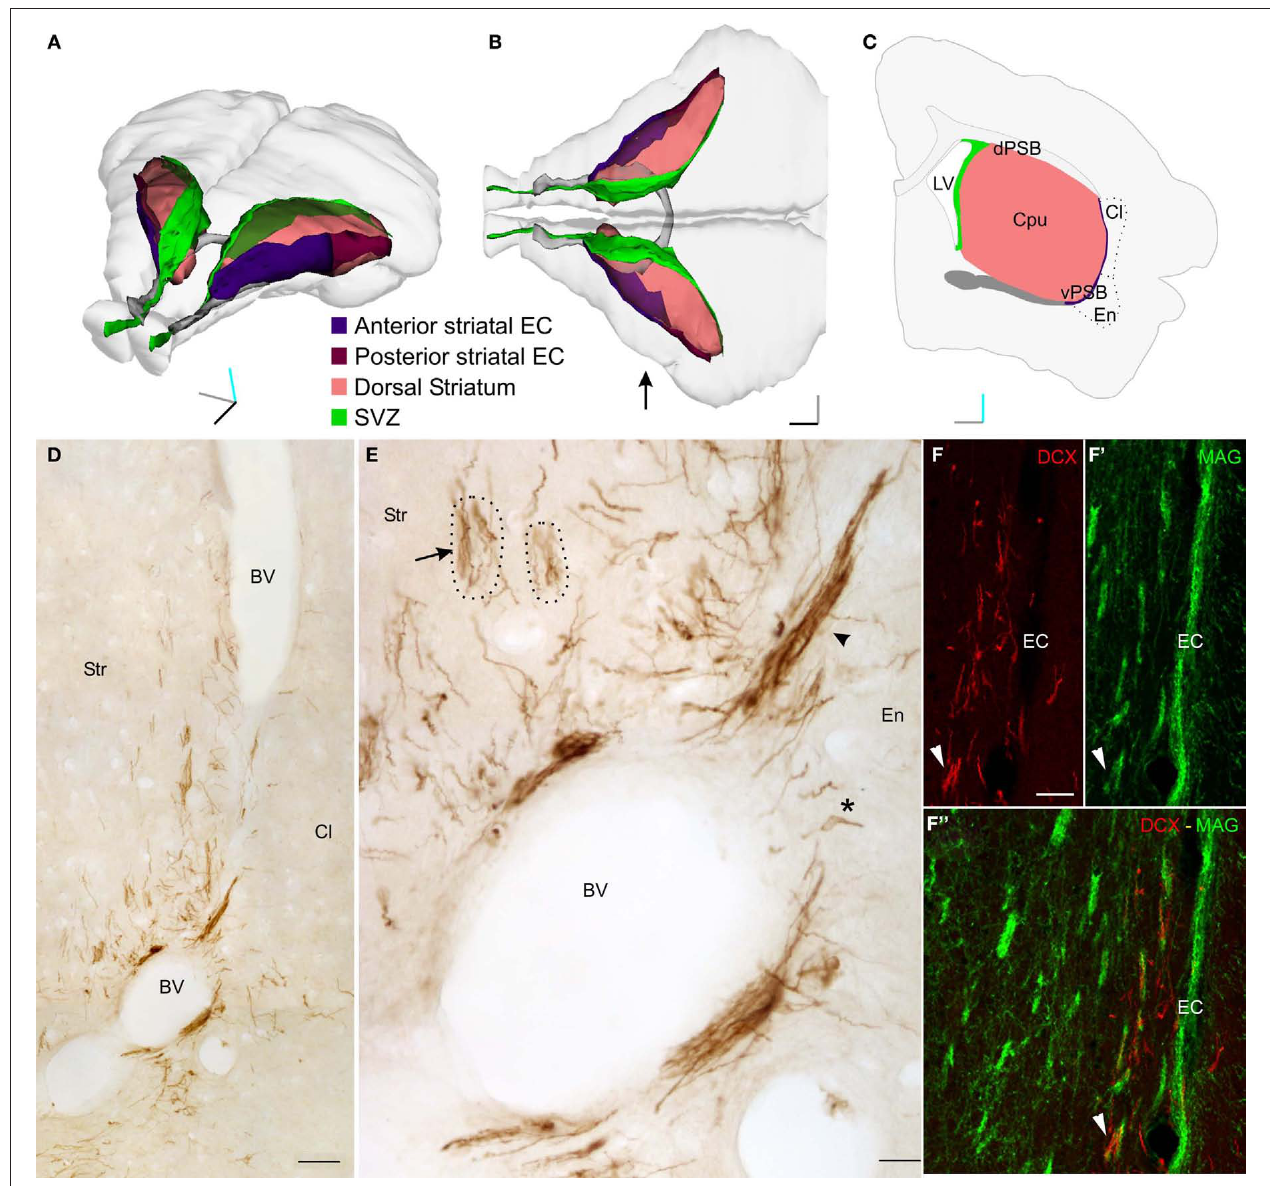
organized either as individual (asterisk) or clustered (arrowheads) elements. In addition, several cell processes, often fascicled (arrow), can be observed. Dotted lines indicate the approximate limits of two internal capsule fiber bundles associated with fascicled DCX processes. (F–F “ ) Double labeling for MAG and DCX showing the close association between fascicles of DCX + processes and internal capsule fiber bundles (arrowhead). Orientation Bars: Gray line: medial; cyan line: dorsal; dark line: rostral. BV: blood vessel; Cl: claustrum; dPSB: dorsal pallial subpallial boundary; vPSB: ventral pallial subpallial boundary; EC: external capsule; Str: Striatum; Scale bars: 80 μm in (D) ; 20 μm in (e) ; 50 μm in (F–F “ )